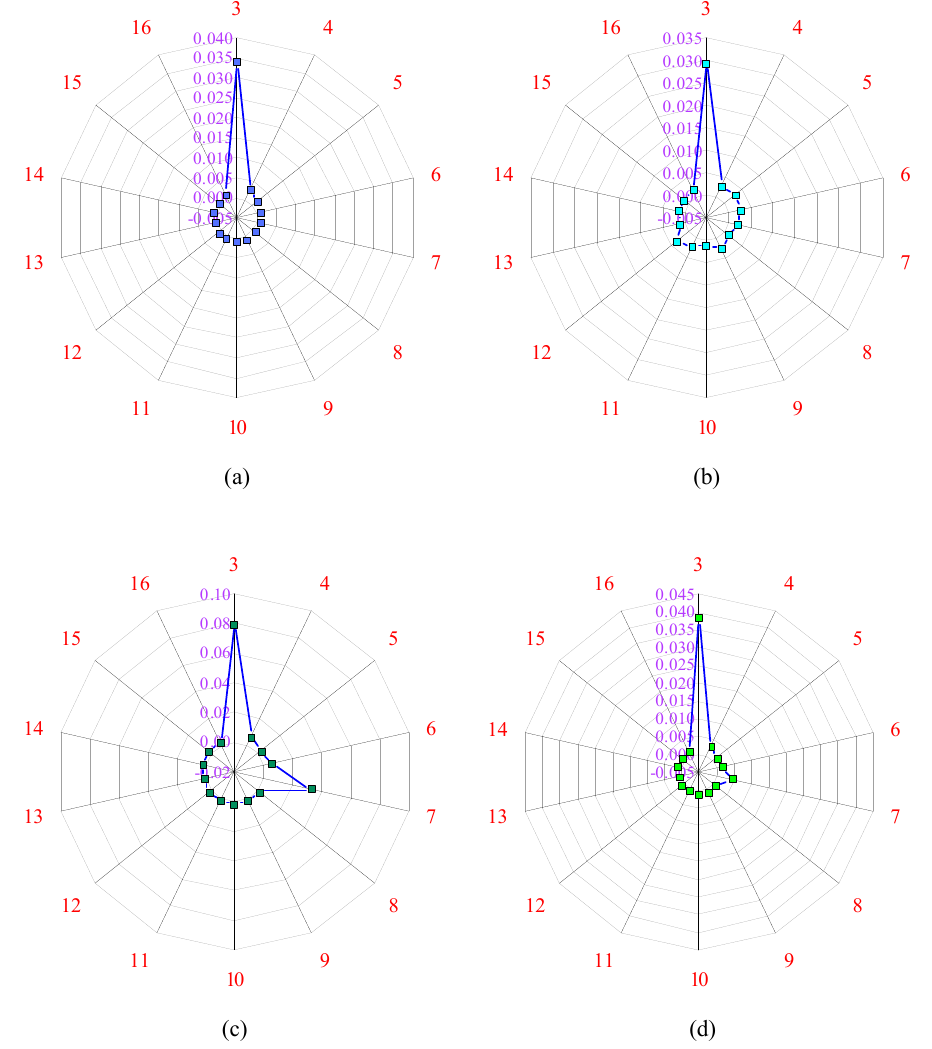
Figure 6. Values of MSE for each neuron; ( a ) training dataset, ( b ) validation dataset, ( c ) testing dataset, ( d ) overall dataset.